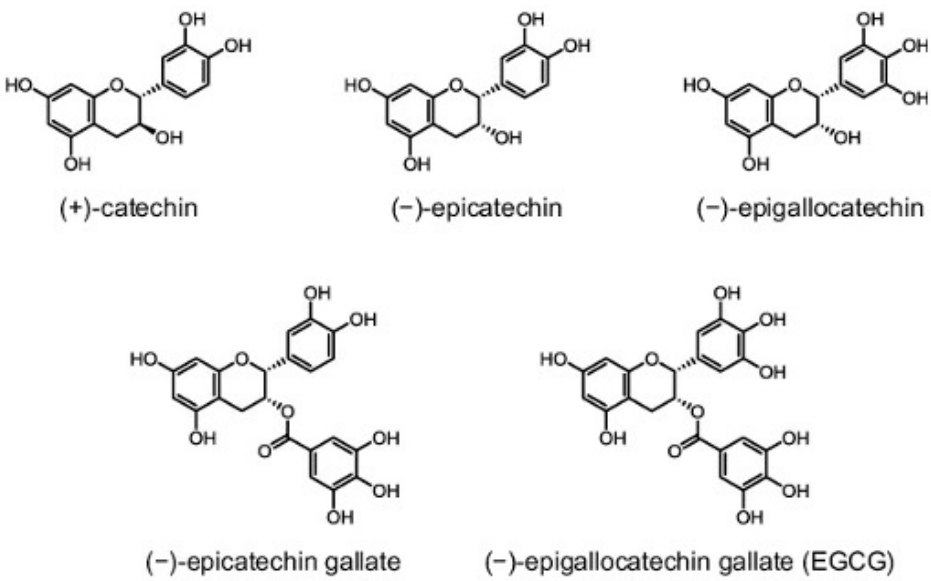
Figure 2. Chemical structure of